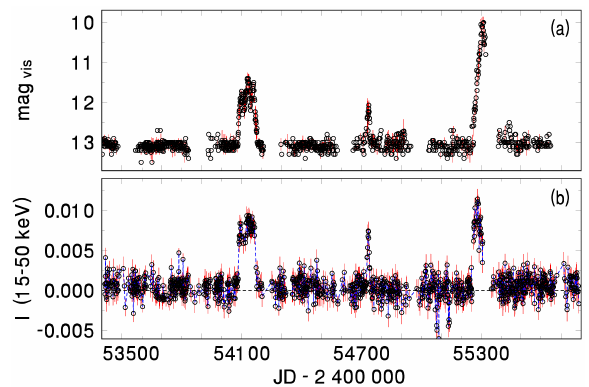
Figure 7: Outbursts of the intermediate polar GK Per in the optical band (AFOEV data) (a) and the hard X- ray band (BAT/ Swift data (data of Krimm et al.